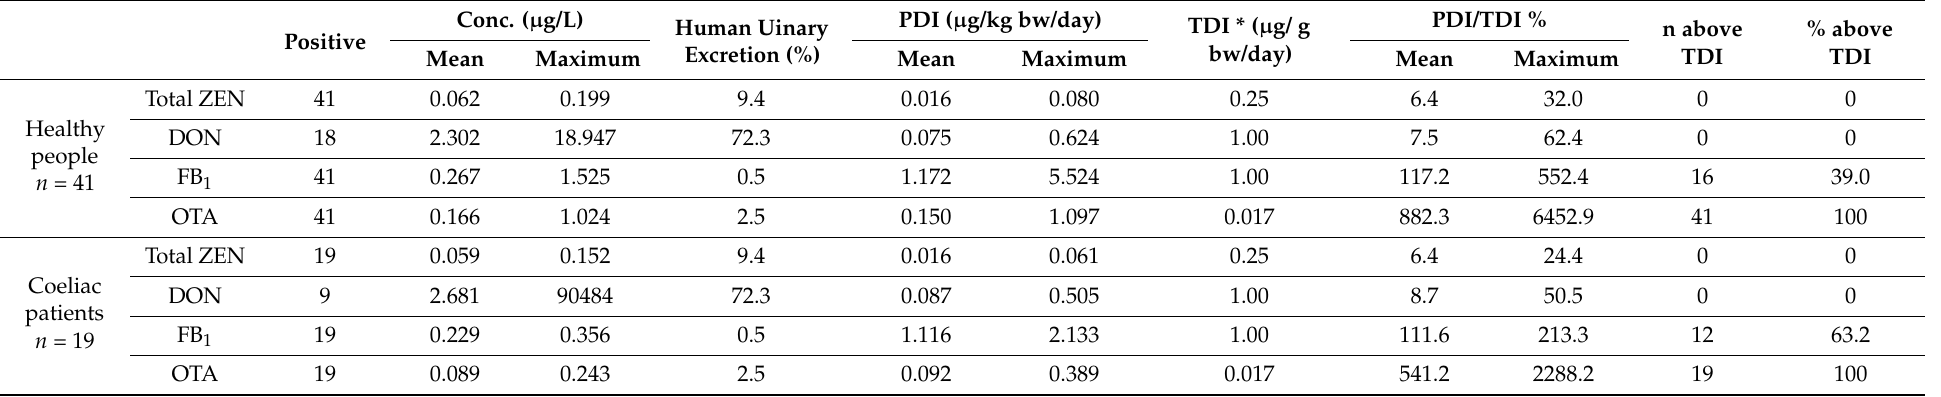
Table 5. Mean and maximum concentration of mycotoxins in human urine samples collected in Hungary from healthy people and coeliac patients and estimated PDI values based on the urinary excretion rate of human